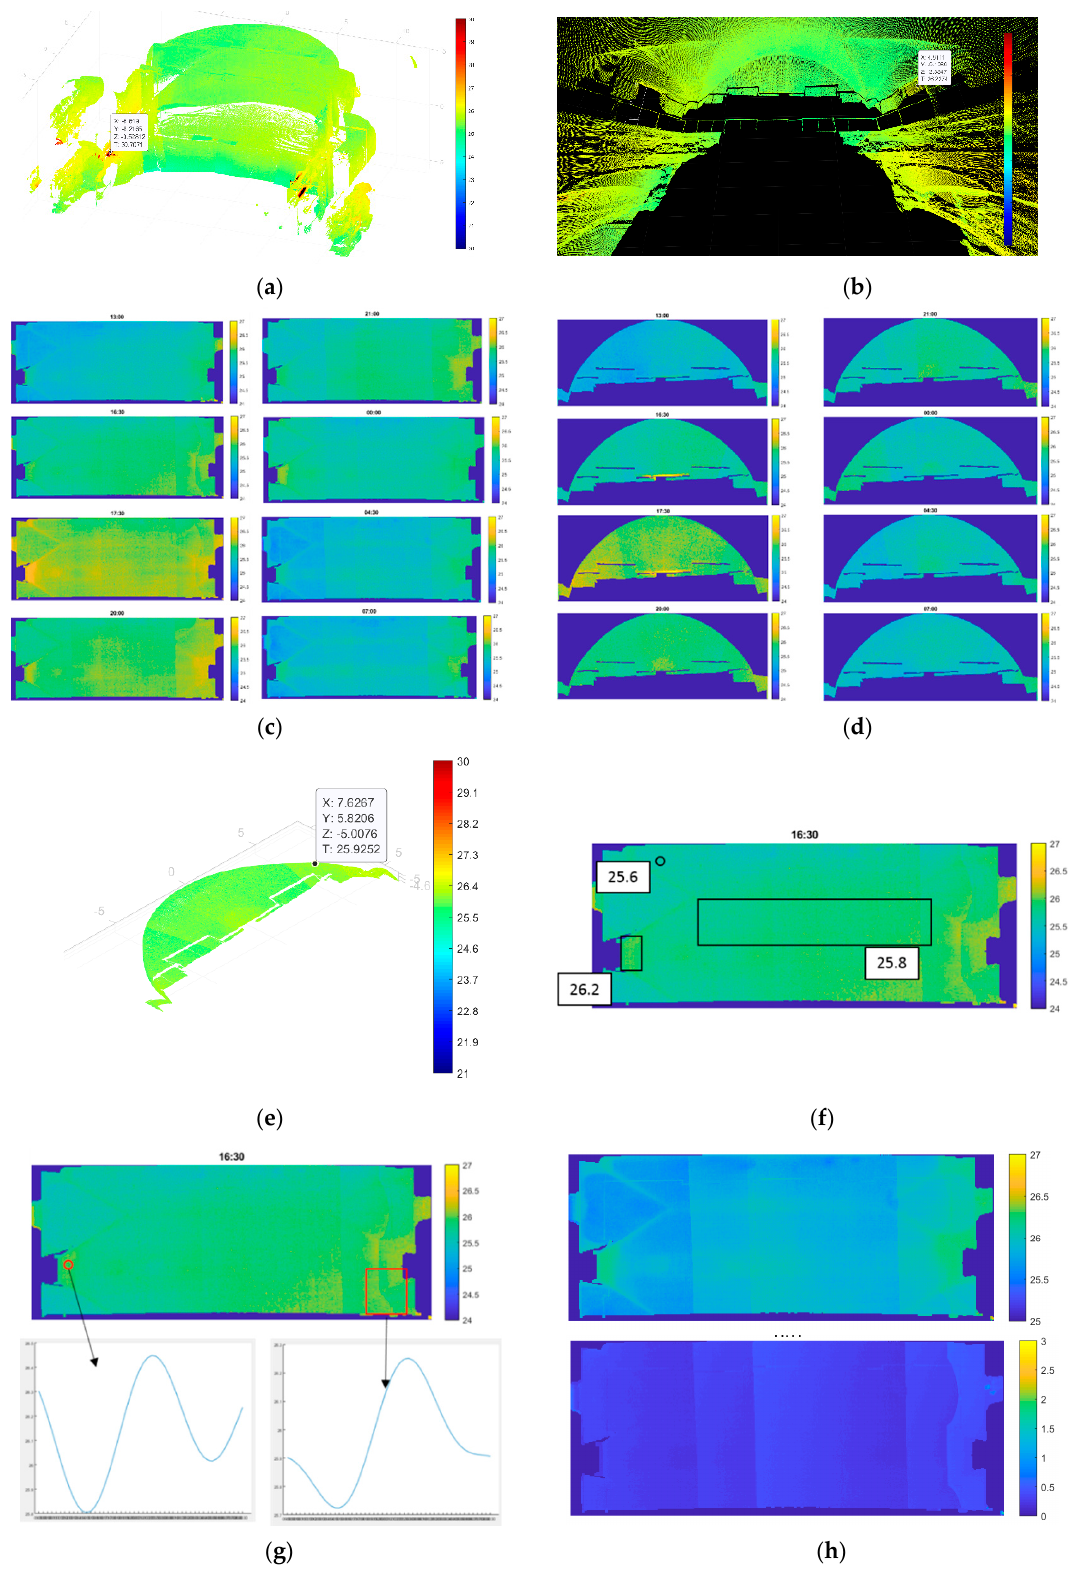
Figure 11 . Visualisation and measurement resources. ( a,b ) Thermal point cloud using two kinds of visual resources. ( c,d ) Thermal orthoimages at different times. ( e ) A 3D representation of a structural element. ( f ) Measurement in thermal orthoimages. ( g ) Thermal evolution over time. ( h ) Mean thermal orthoimage and standard deviation image.